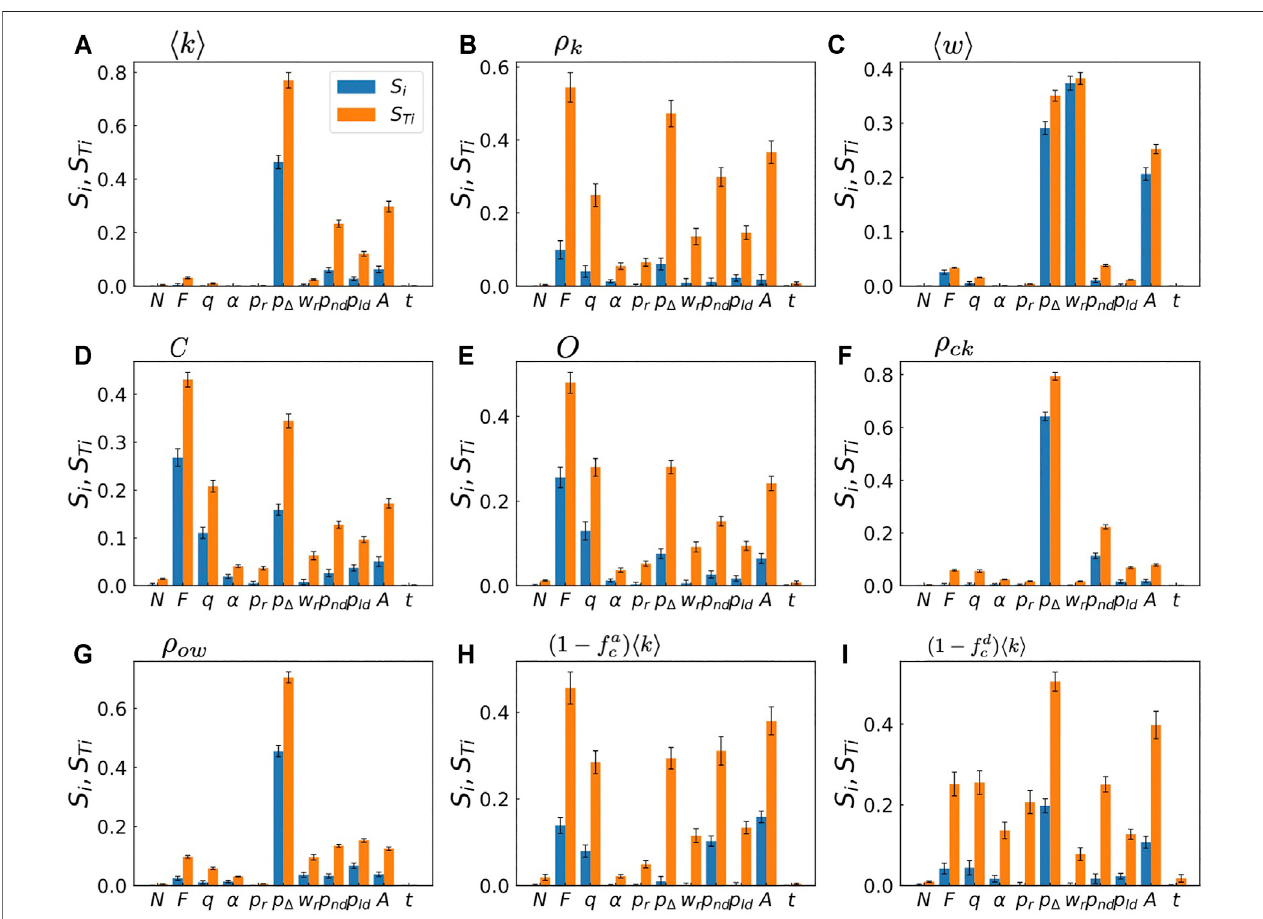
FIGURE 4 | Sensitivity analysis of the metamodel. The fi rst-order index S i and the total-effect index S Ti of each input parameter ( Table 1 ) against each output ( Table 2 ) are shown with error bars indicating the 95 % con fi dence intervals. See Eqs. 5 , 6 for de fi nitions of S i and S Ti , respectively.